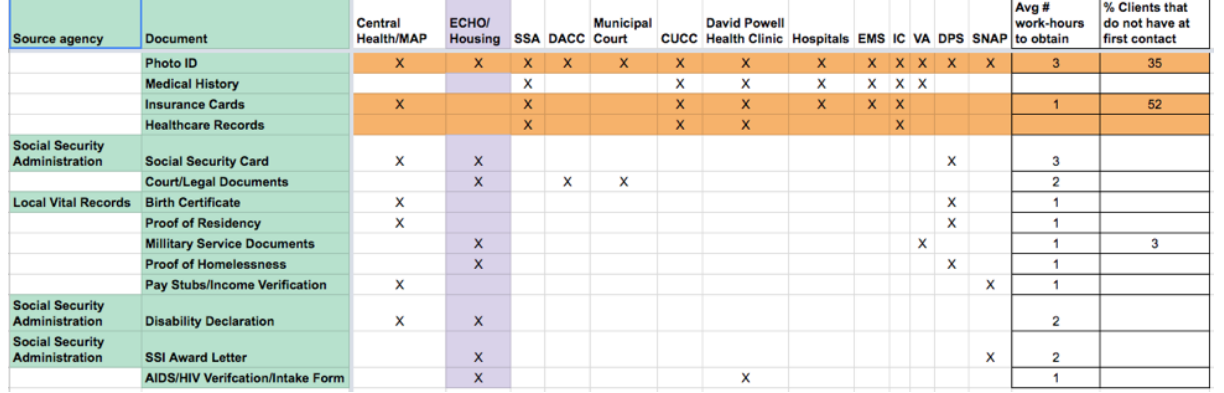
Figure 1. Documents needed across service providers and their homeless clients. CUCC: Community Care Clinics; DACC: Downtown Austin Community Court ; DPS: Department of Public Safety; ECHO: Ending Community Homelessness Coalition; EMS: Emergency Medical Services; IC: Integral Care; SNAP: Supplemental Nutrition Assistance Program; SSA: Social Security Administration; VA: